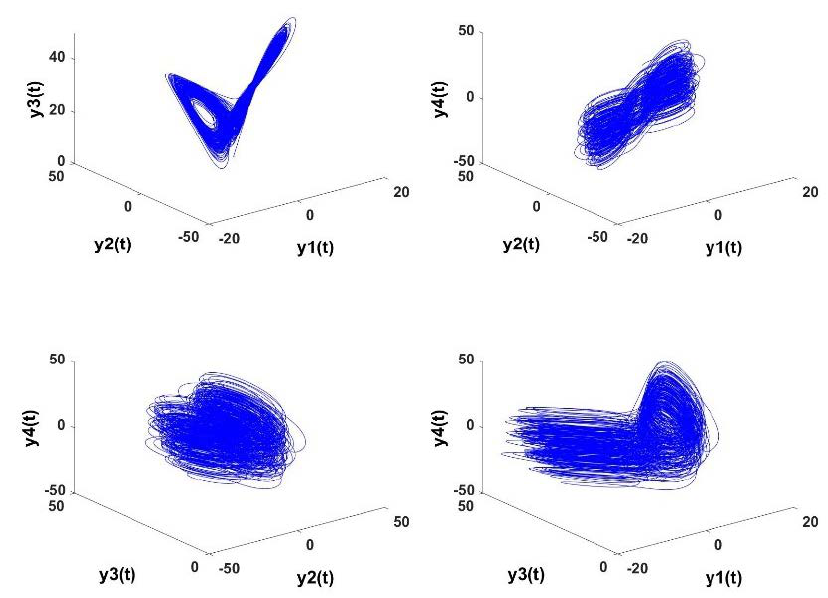
Figure 2. Attractors of the slave system (30) when q = 0.94 and u 1 = u 2 = u 3 = u 4 =